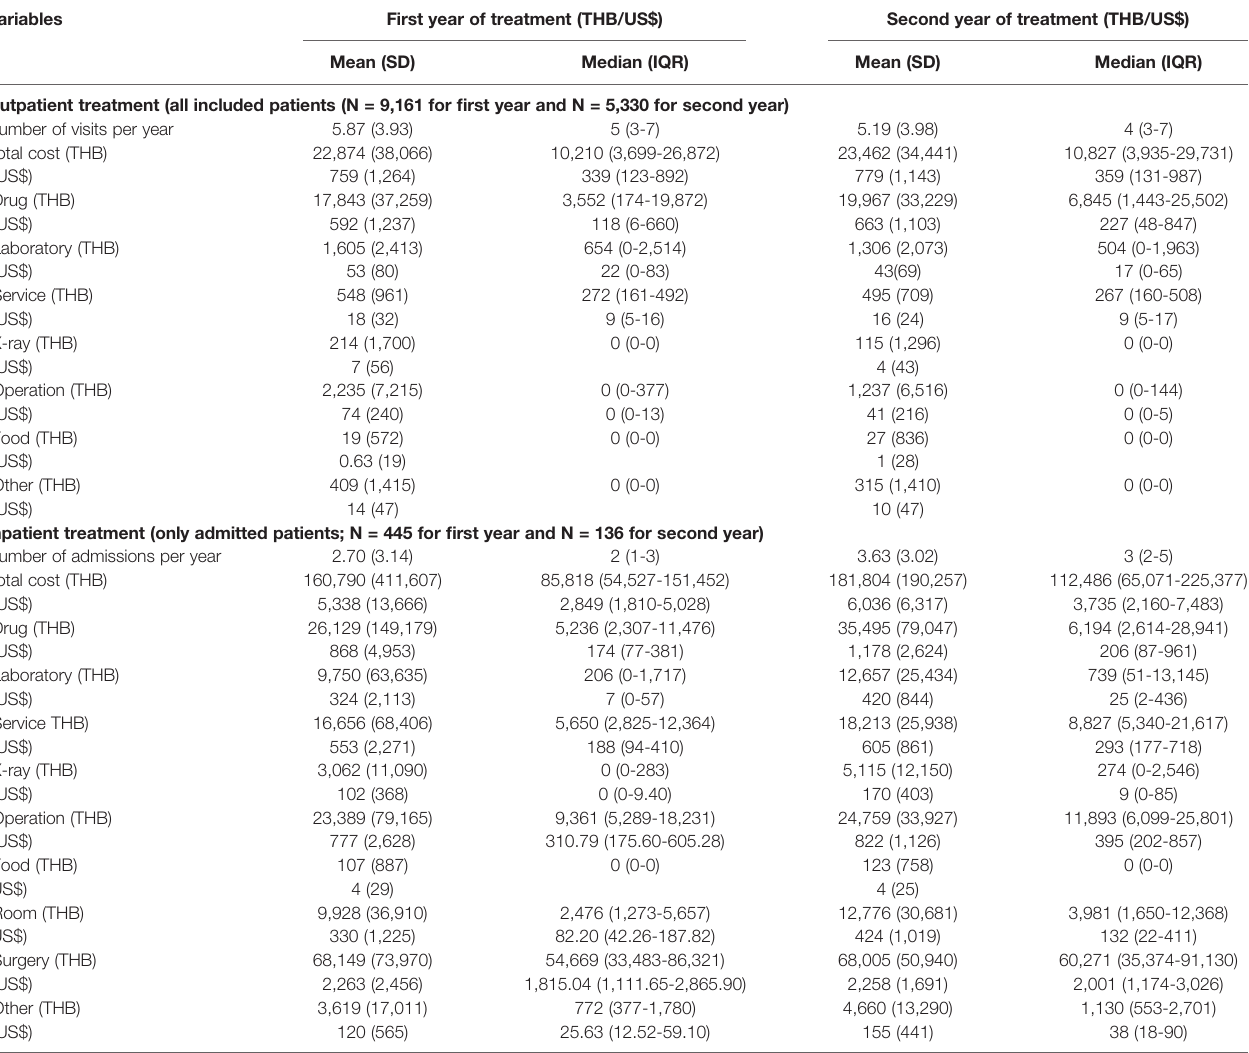
TABLE 2 | Economic burden of type 2 diabetes treatment.